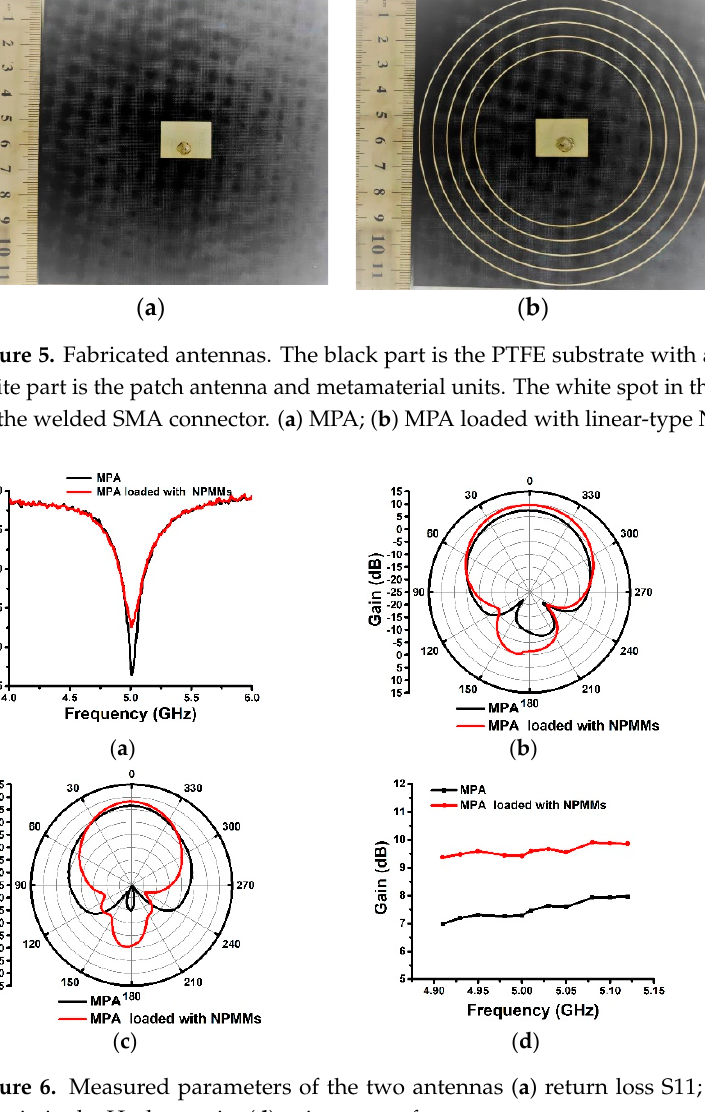
(7) where G is the gain of antenna, and λ is wavelength. The A (cid:2915) of conventional MPA is 16 cm 2 , and the A (cid:2915) of MPA loaded with NPMMs is 26 cm 2 . Therefore, the aperture efficiency is also improved. From the above analysis, it can be drawn that the linear-type NPMMs can greatly improve the performance of MPA. Figure 6d shows the gain comparison of 11 frequencies measured from 4.91 to 5.12 GHz. Since linear-type metamaterials have negative permeability at 1–10 GHz, when the surface wave passes through the linear-type metamaterials, a resonance forbidden gap appears. It can be seen from Figure 6d that the gain of these 11 points is increased obvi- ously. Therefore, the surface wave can be minimized to improve the performance of MAP well. 5. Conclusions In order to adopt metamaterials to improve the EM performance of UWB or multi- band microstrip antennas, this paper proposes a novel MPA based on linear-type NPMMs substrate. The simulations and measurements consistently manifest that without chang- ing the center frequency and bandwidth of the conventional MPA, the gain is improved by 2.12 dB. In addition, the HPBW of the H-plate is reduced by 14° and the effective area is increased by 62.5%. The linear-type metamaterials have small machining error due to its simple structure. This MPA loaded with NPMMs is easy to manufacture by a printed circuit board, and it can be conveniently applied to aircraft conformal antennas, wireless energy harvesting (WEH) systems, and so on. Author Contributions: Conceptualization, W.-H.H. and Y.G.; methodology, X.-P.Z.; writing—orig- inal draft preparation, W.-H.H.; writing—review and editing, W.-H.H. and Y.G.; supervision, X.- P.Z.; project administration, X.-P.Z.; funding acquisition, X.-P.Z. All authors have read and agreed to the published version of the manuscript. Funding: This research was funded by the National Natural Science Foundation of China, grant number 11674267, 51272215 and the National Key Scientific Program of China, grant number No.2012CB921503. Institutional Review Board Statement: Not applicable. Informed Consent Statement: Not applicable.